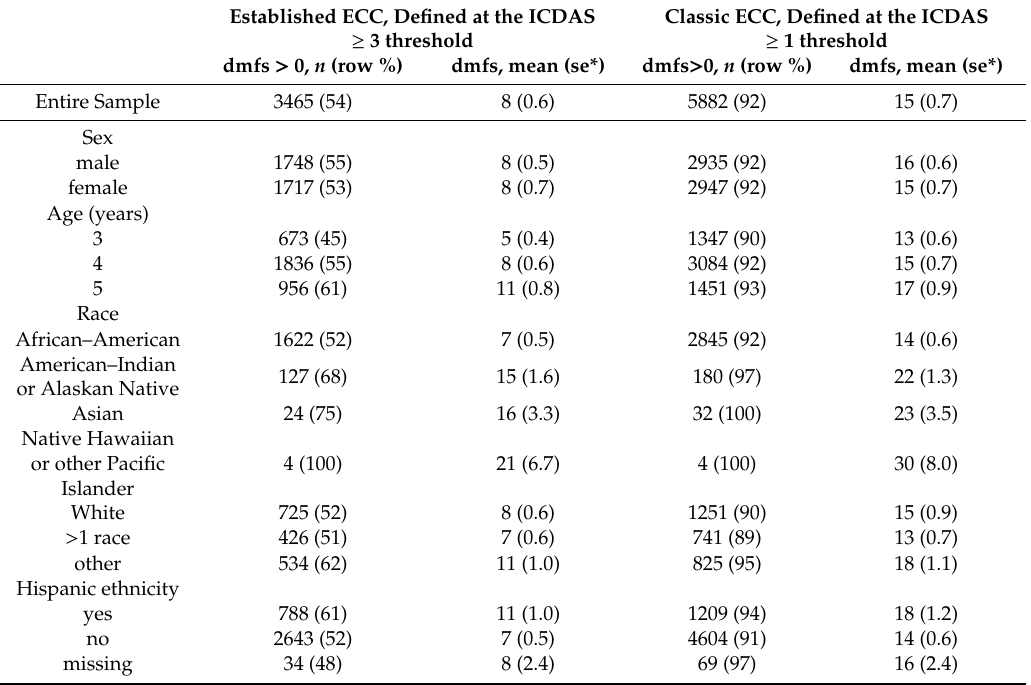
Table 4. Estimates of early childhood caries (ECC) experience (case status, defined as one or more decayed, missing, or filled tooth surface (dmfs) due to dental caries) and burden (dmfs) overall and according to participants’ demographic characteristics in the ZOE 2.0 study, North Carolina, 2016–2019. Two thresholds of caries lesion detection according to the International Caries Detection and Assessment System (ICDAS) are used—ICDAS ≥ 3 (established ECC) and ICDAS ≥ 1 (classic